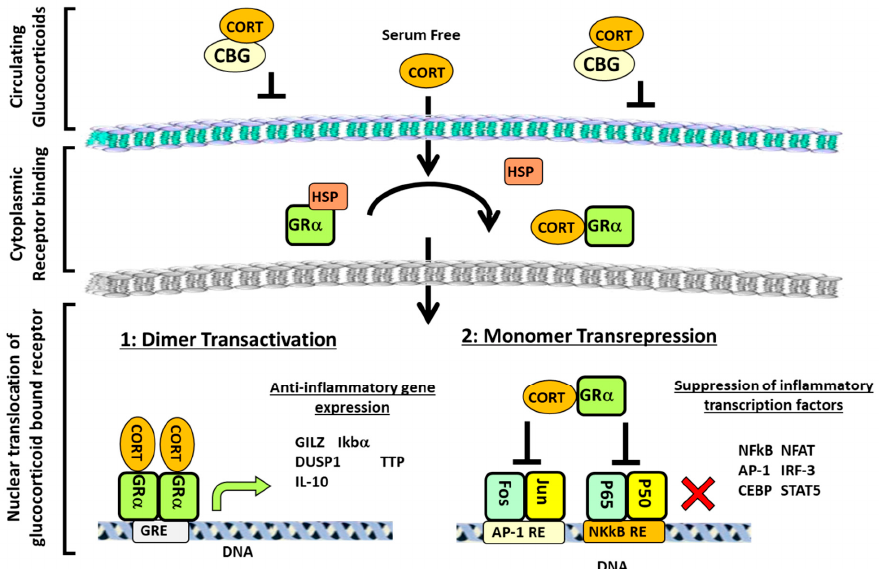
Figure 1. Overview of glucocorticoid (GC) signalling pathways. The majority of glucocorticoids (GCs) in the circulation are bound by corticosteroid-binding globulin (CBG), which prevents diffusion across the membrane. However, free GCs can readily enter the cell, where they bind to the GR in the cytoplasm. This induces a conformational change in the glucocorticoid receptor (GR), which causes the dissociation of chaperone molecules, such as heat shock proteins (HSPs), to expose the nuclear localisation signal (NLS) and allow translocation of the GC/GR complex to the nucleus. Here, the GR can either dimerise to transactivate anti-inflammatory genes or signal as a monomer to inhibit pro-inflammatory transcription factors. Cortisol (CORT), nuclear factor of activated T-cells (NFAT), CCAAT-enhancer-binding proteins (or C/EBPs), nuclear factor kappa-light-chain-enhancer of activated B cells (NF- κ B), p38 mitogen-activated protein kinases (p-38-MAPK), glucocorticoid induced leucine zipper (GILZ), secretory leukocyte protease inhibitor (SLPI), tristetraprolin (TTP), mitogen-activated protein kinase-1 (MKP-1), activator protein 1 (AP-1), signal transducer and activator of transcription 5 (STAT5), and response element (RE).